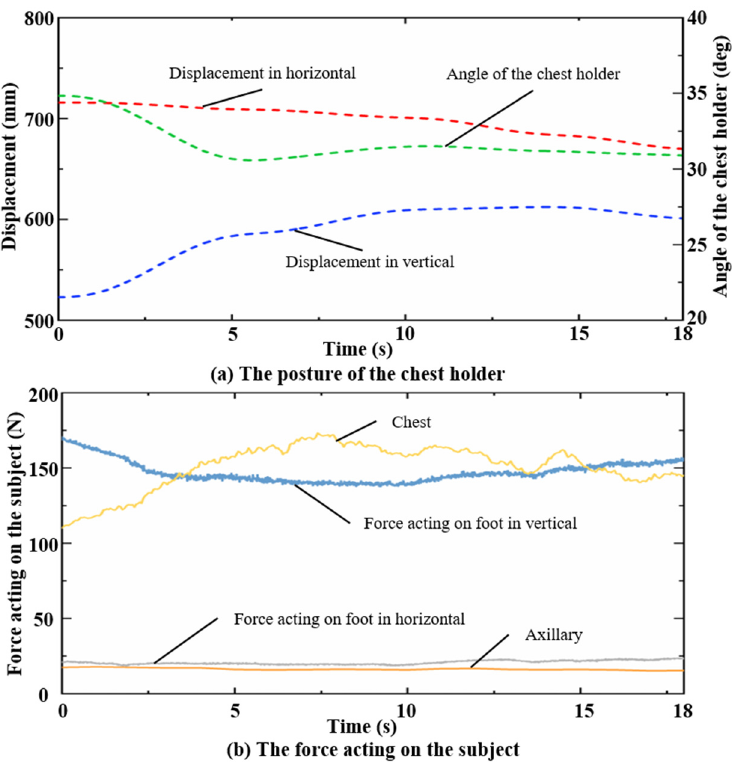
Figure 3. The relationship between forces acting on the subject and the posture of the chest holder: ( a ) the posture of the chest holder; ( b ) the force acting on the subject.